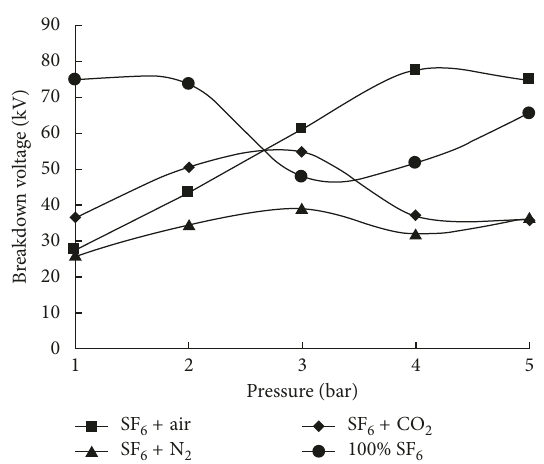
Figure 6: Changing of breakdown voltage with gas pressure for 100% SF 6 and 0.125% SF 6